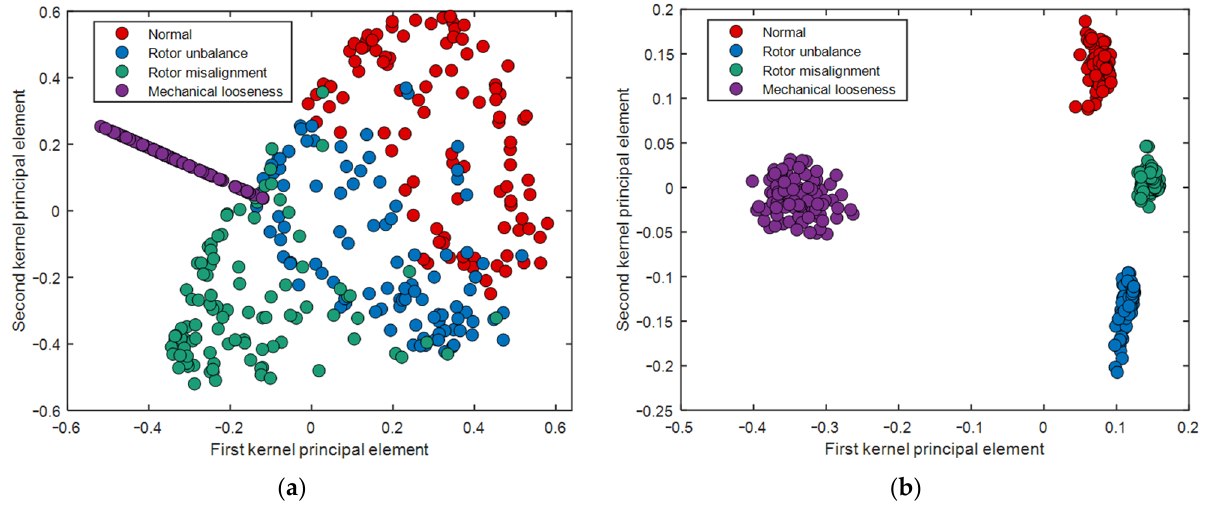
Figure 7. Test sample feature extraction effect. ( a ) KPCA method ( b ) WKPCA